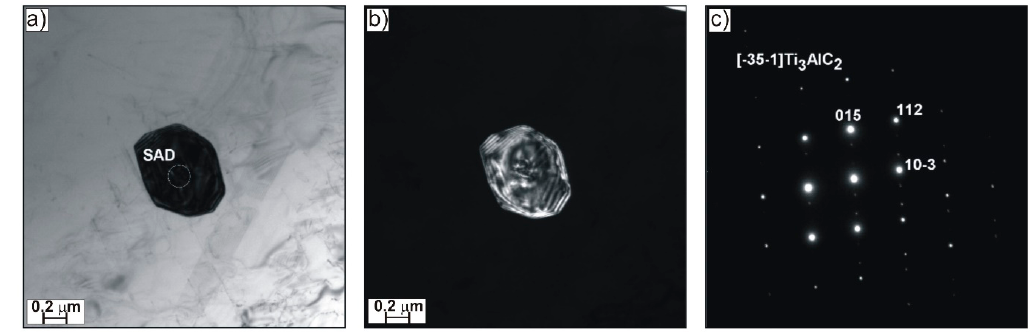
Figure 3. Ti 3 AlC 2 phase precipitates in the Ti–45Al–8Nb–0.5(B, C) alloy: bright field ( a ), dark field ( b ), and electron diffraction ( c ).